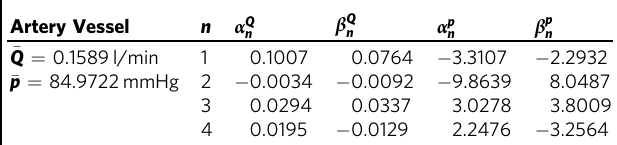
Table 2 Parameters of velocity and pressure waveform equations. Artery Vessel